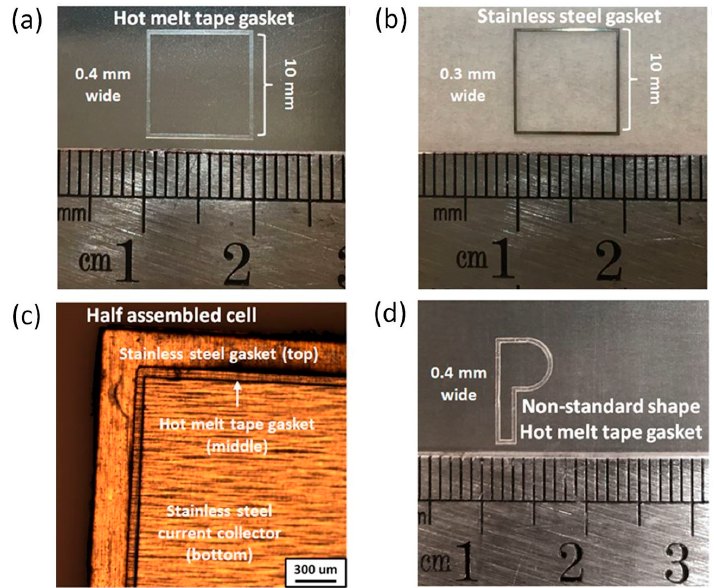
Figure 2. ( a ) Optical image of a precision-machined hot melt tape gasket. ( b ) Optical image of